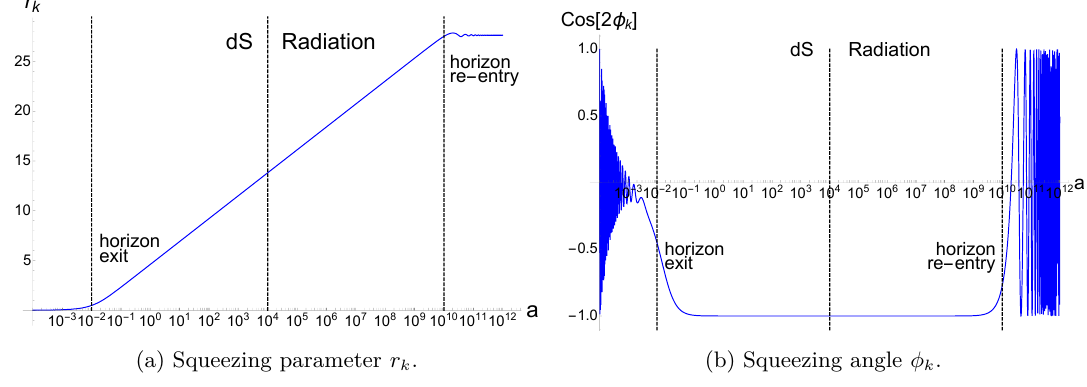
Figure 6. The squeezing parameter and squeezing angle of a pure state cosmological perturba- tion (3.25) with fixed k are shown for a simple model of the early Universe consisting of a period of de Sitter accelerated expansion, followed by radiation domiation. The squeezing parameter r k grows while the mode is outside the horizon, while φ k ≈ − π/ 2 there. When the mode eventually re-enters the horizon the squeezing parameter “freezes in”, while the squeezing angle begins to grow, causing rapid oscillations in cos(2 φ k )